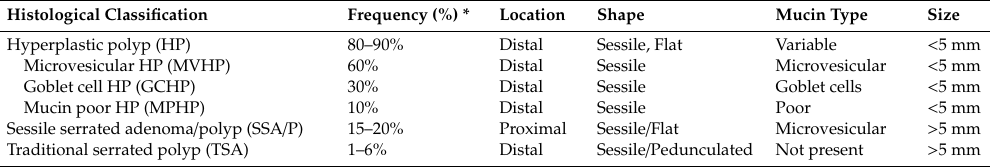
Table 1. Morphologic categories and features of serrated colorectal